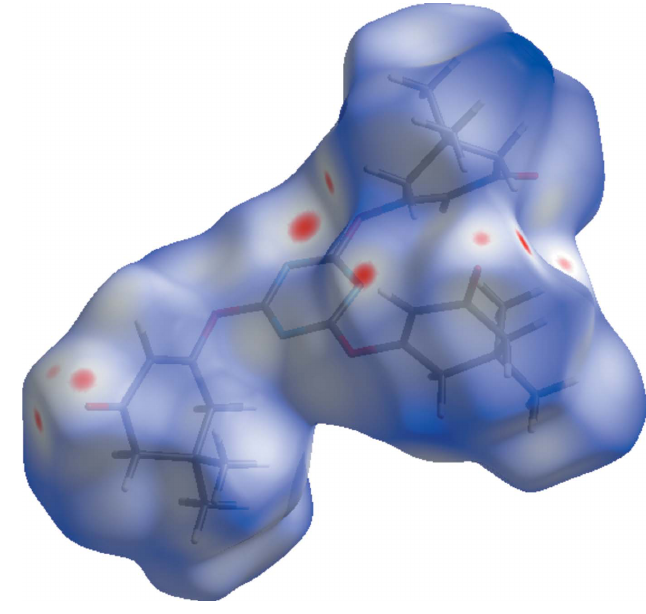
Figure 3 Hirshfeld surface of the title compound mapped over d norm .